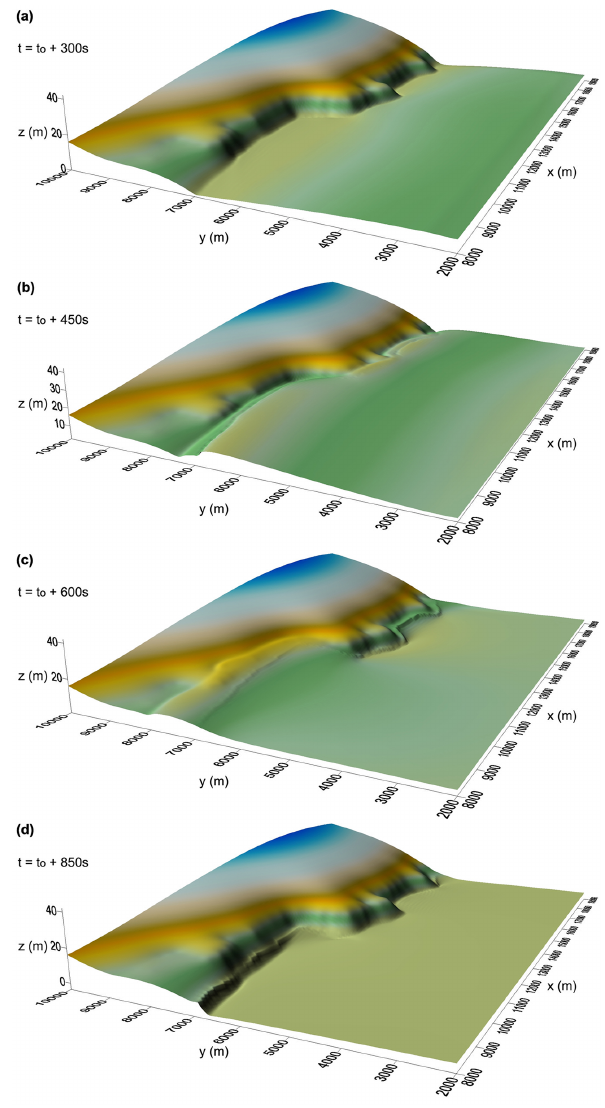
Figure 11. Snapshots of the evolution of inundation at the coasts of southwest Crete (see also Fig. 6a) for an exemplary exaggerated tsunami scenario (normalized wave amplitude of ζ 0 = 6m at gen- eration), presenting: (a) the propagation of the tsunami wave to the nearshore; (b) the wave breaking at the lower part and the run-up at the upper part of the figure; (c) the run-up at the lower part and run-down at the upper part of the figure; and (d) the run-down at the lower part of the